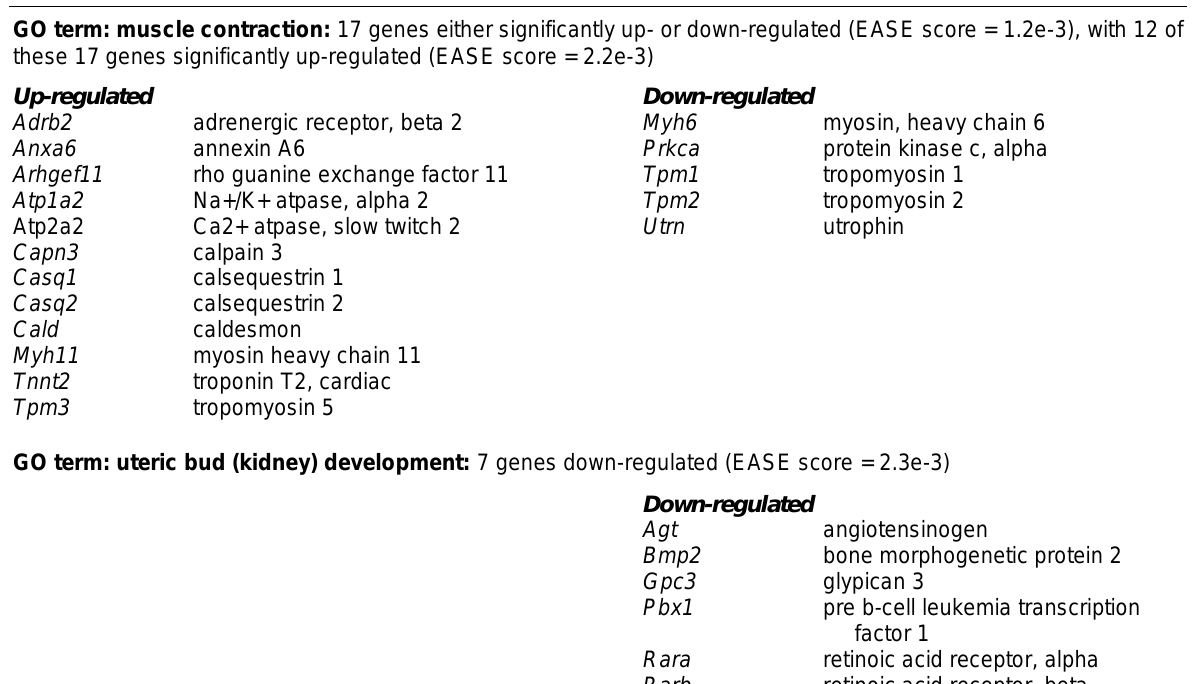
GO and KEGG Term